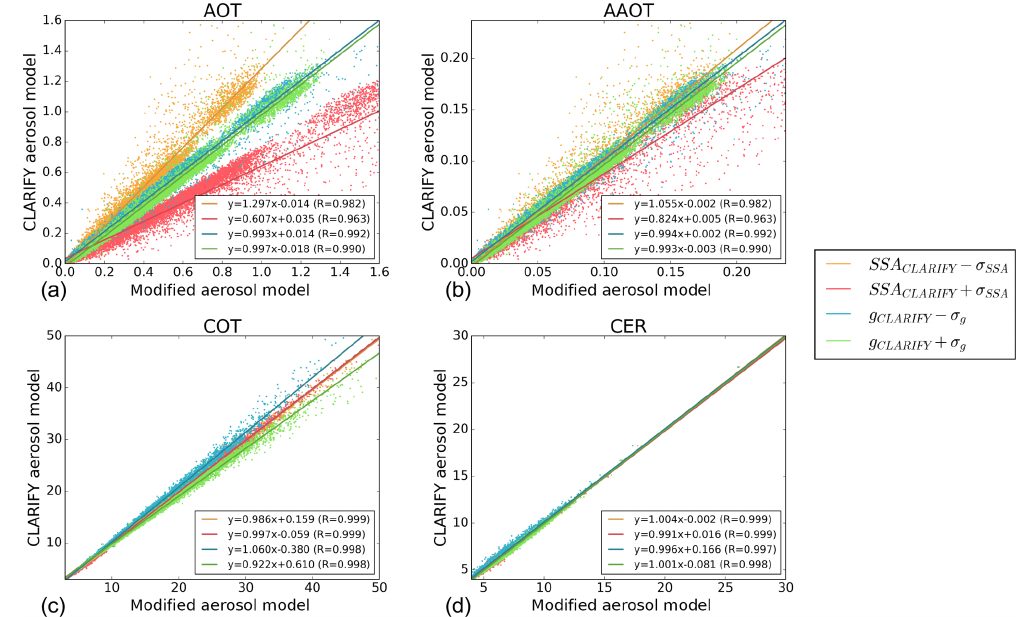
Figure 9. Impact of the assumption on the SSA and the asymmetry factor g on the retrieved aerosol and cloud properties. AOT, AAOT, COT and CER obtained for 28 August 2017 at 10:12UTC with the CLARIFY-2017 model are plotted against the properties retrieved with the modified aerosol models.